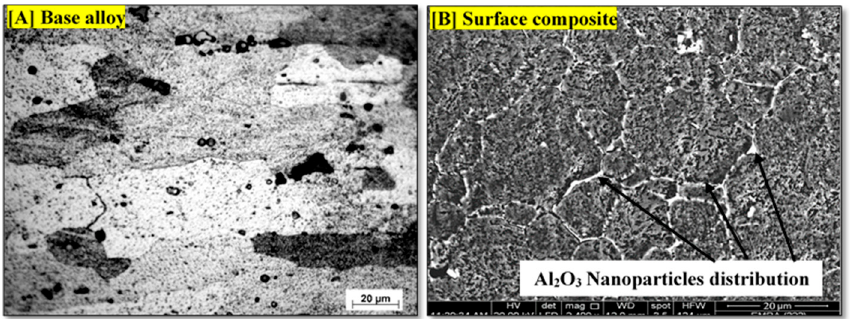
Figure 10. ( A ) Microstructure of 2024 base alloy; and ( B ) Al 2 O 3 nanoparticles dispersion in the surface composite fabricated by FSP.